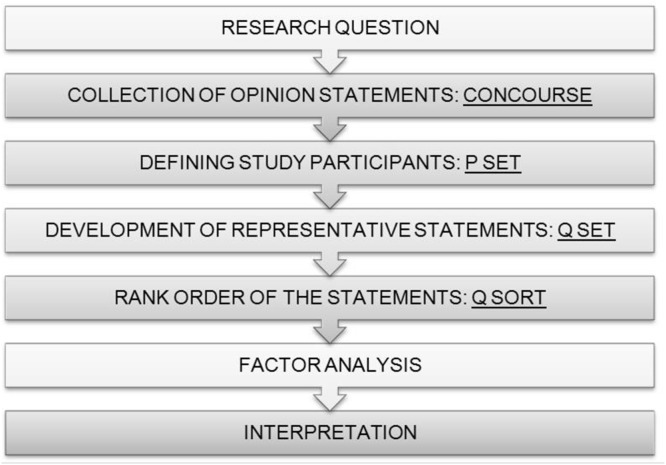
Steps in Q methodology.(Cross, 2005).